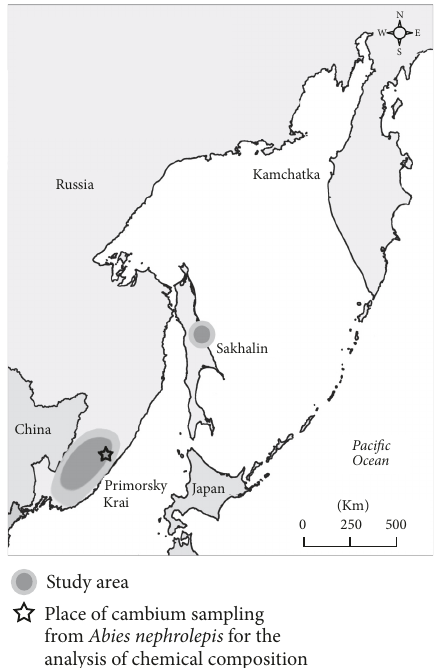
Figure 1: Map of observations was made during the period from 1998 to